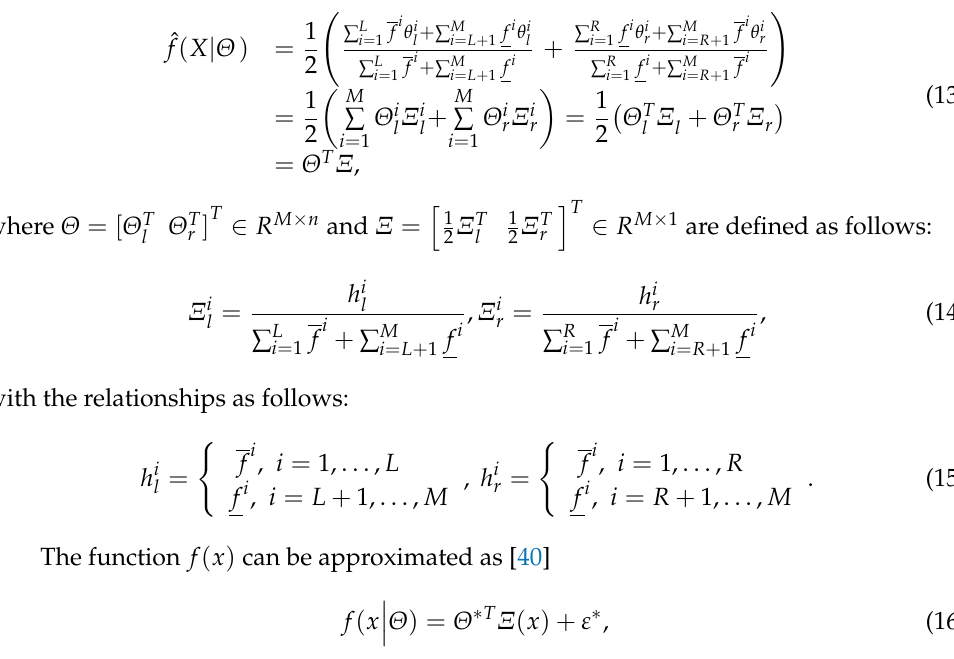
Figure 1. ( a ) Schematic diagram of IT2-FLS. ( b ) IT2-fuzzy Gaussian